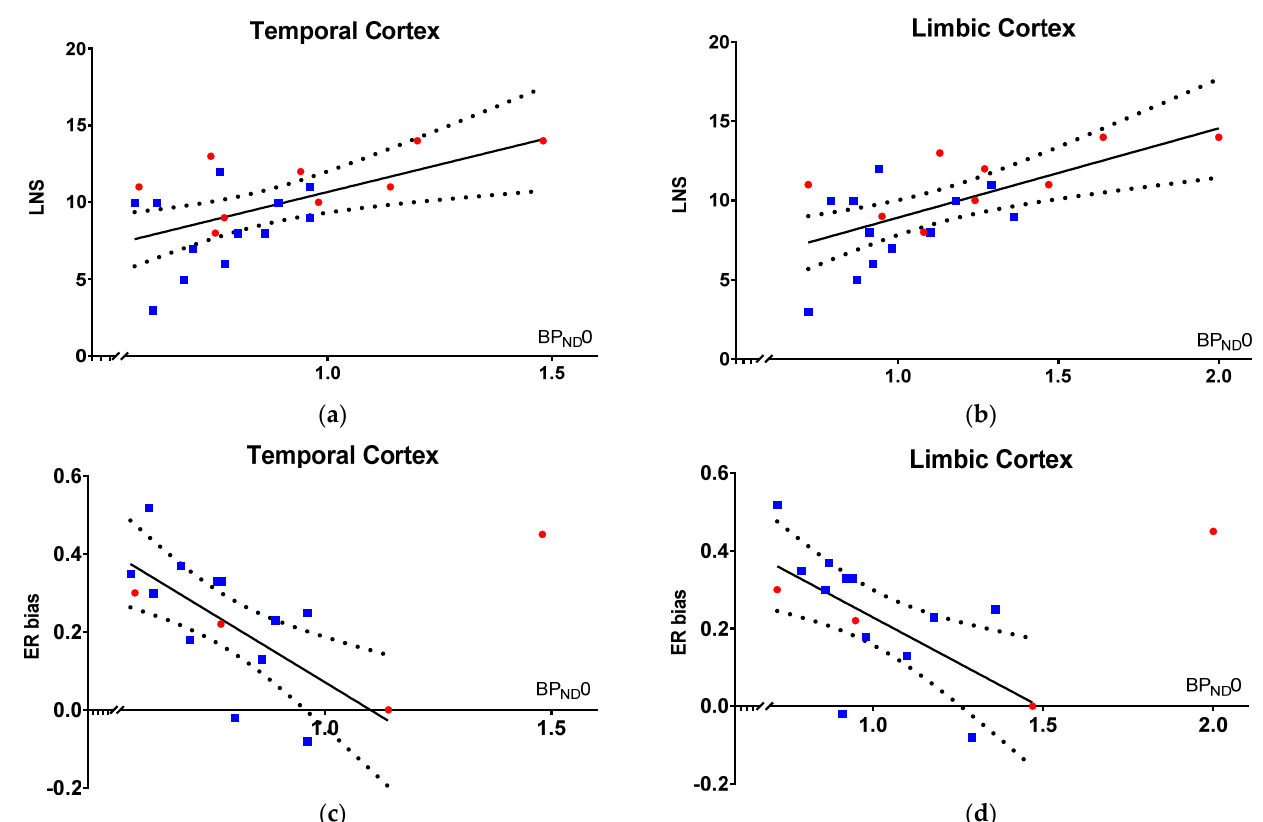
Figure 1. 5-HT1BR PET binding vs cold and hot cognition at baseline. [ 11 C]AZ10419369 BP ND 0 in PD patients (blue squares) and controls (red circles) versus: ( a,b ) LNS score in the temporal and limbic cortex; ( c,d ) ER bias in the temporal and limbic cortex. One control, with ER bias as outlier (>2SD), was excluded from the regression analyses. LNS and ERbias are anticorrelated at a sub-significant level (Spearman correlation coefficient − 0.29, p = 0.27).